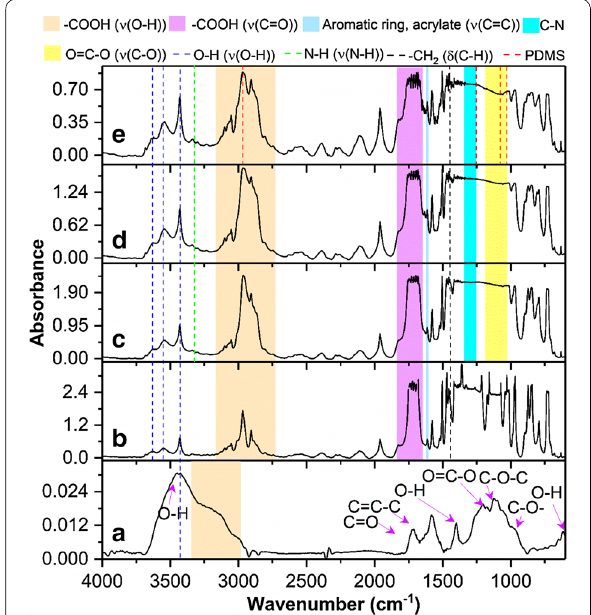
Fig. 2 The Fourier transform infrared (FTIR) spectra of (a) GO, (b) PET, (c) PUA film, (d) GO incorporated PUA composite film (PG) and (e) siloxane functionalized GO incorporated PUA composite film